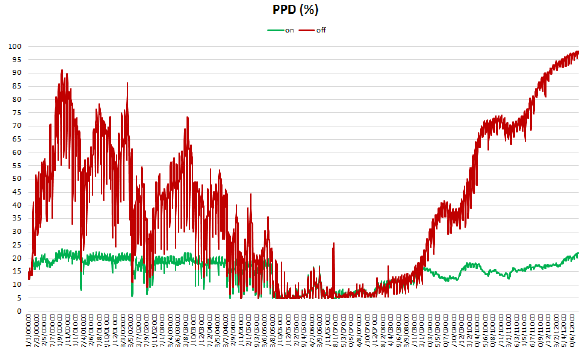
Figure 11: PPD Simulation, HVAC on-off, room Croce Centrale, IES.VE